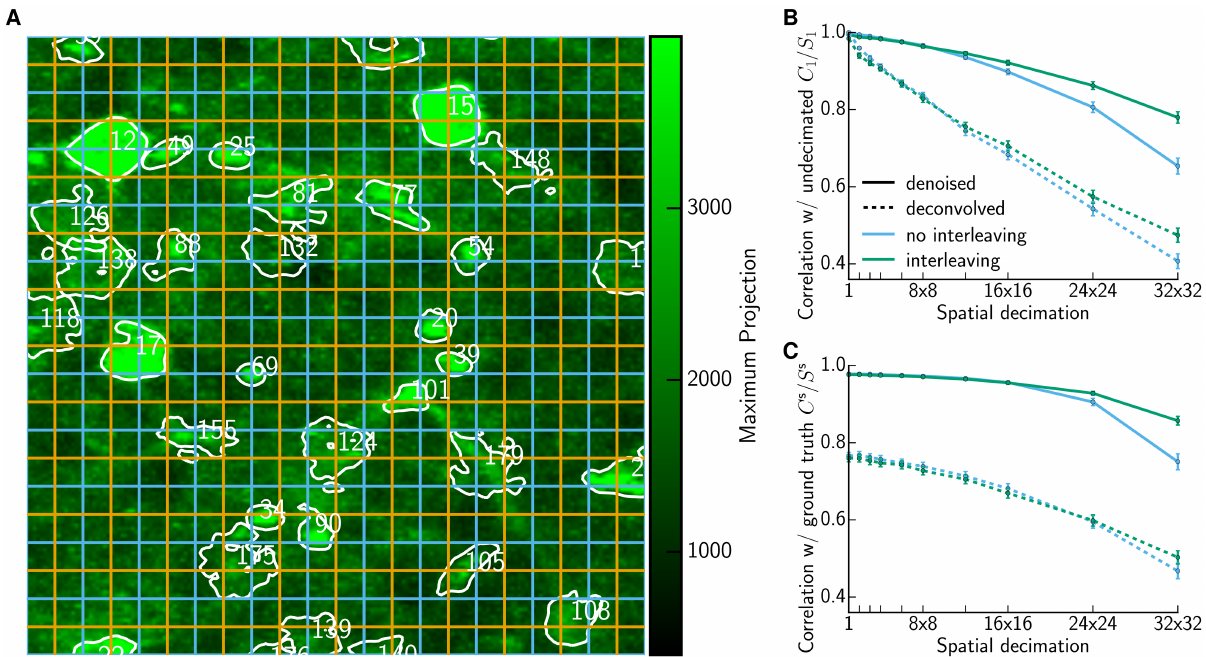
Fig 8. Interleaving improves accuracyof recovered C l at low spatial resolution. (A) Interleaving alternates betweenpixels correspondingto the cyan and orangegrid. (B) Correlationbetweentraces C l obtainedon decimateddata and the reference C 1 obtained without any decimation. The averagecorrelation( ± SEM)decays faster without (cyan) than with interleaving(green). Similar results hold for median and IQR, but the resulting plot is too cluttered. (C) Comparingto simulatedgroundtruth C s . Traces were obtained on decimateddata with reshuffled residuals, otherwiseanalogousto